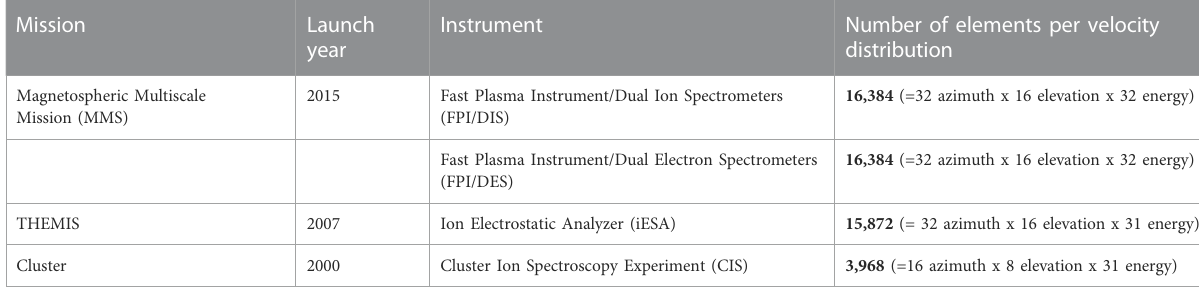
TABLE 1 Number of elements per velocity distribution for various plasma instruments. Mission Launch year